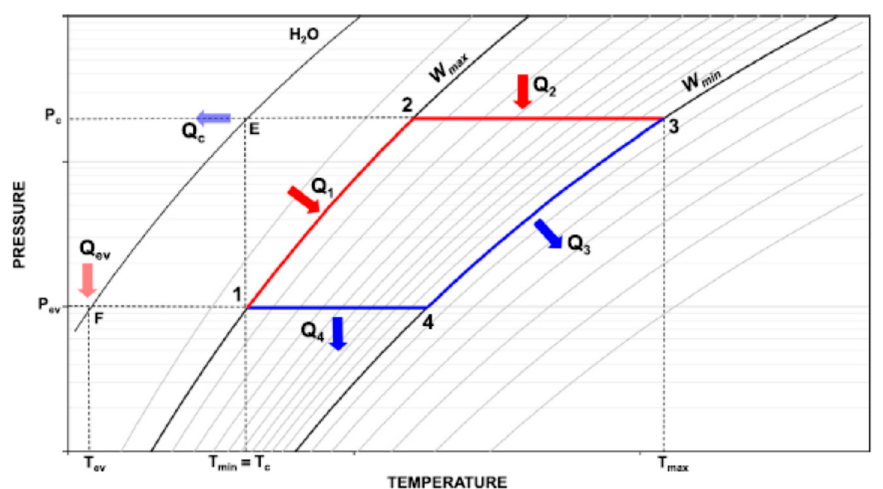
Figure 2. Physical-adsorption map.